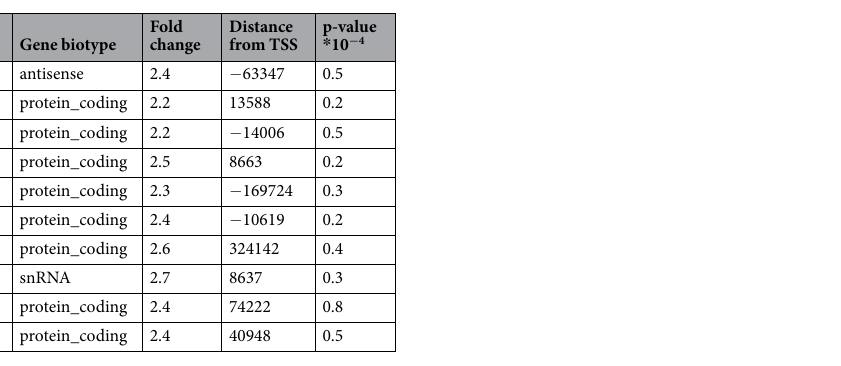
Table 2. List of the top 10 genes showing increase in H3K9 acetylation after DAC